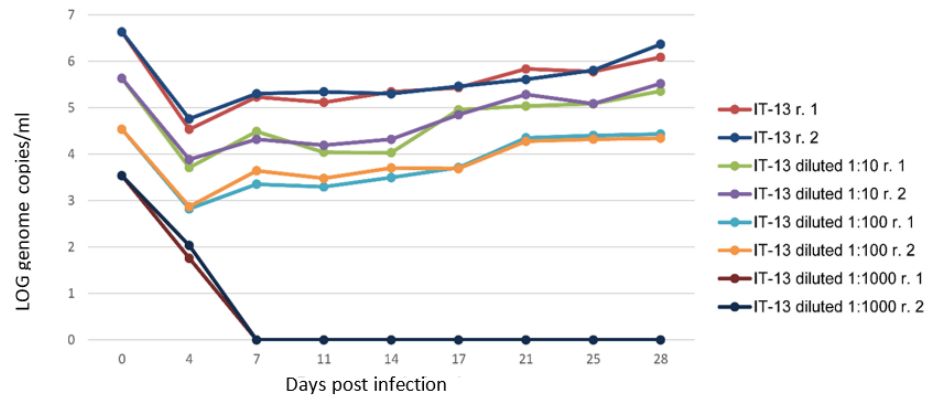
Figure 4. Estimation of minimum infectious dose (MID) of the IT-13 strain. The HEV-RNA in culture supernatants of A549 cells inoculated with serial ten-fold dilutions of HEV stocks was estimated as Log10 genome copies/mL for 28 days p.i. The r.1 and r.2 in legend represent the replicates.